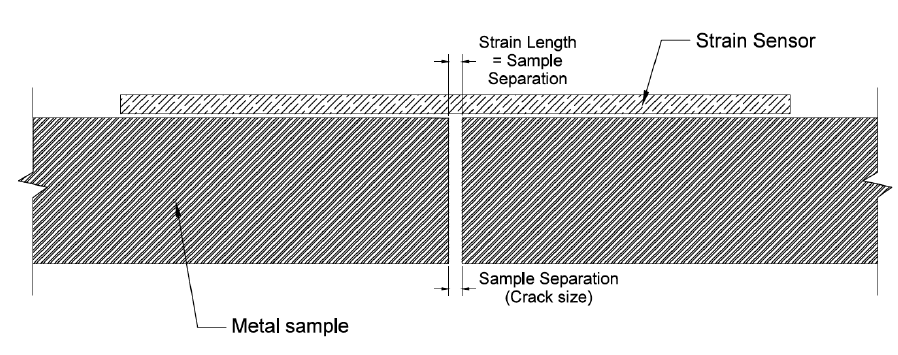
Figure 5. Strain length vs. sample separation on non-degrading materials.